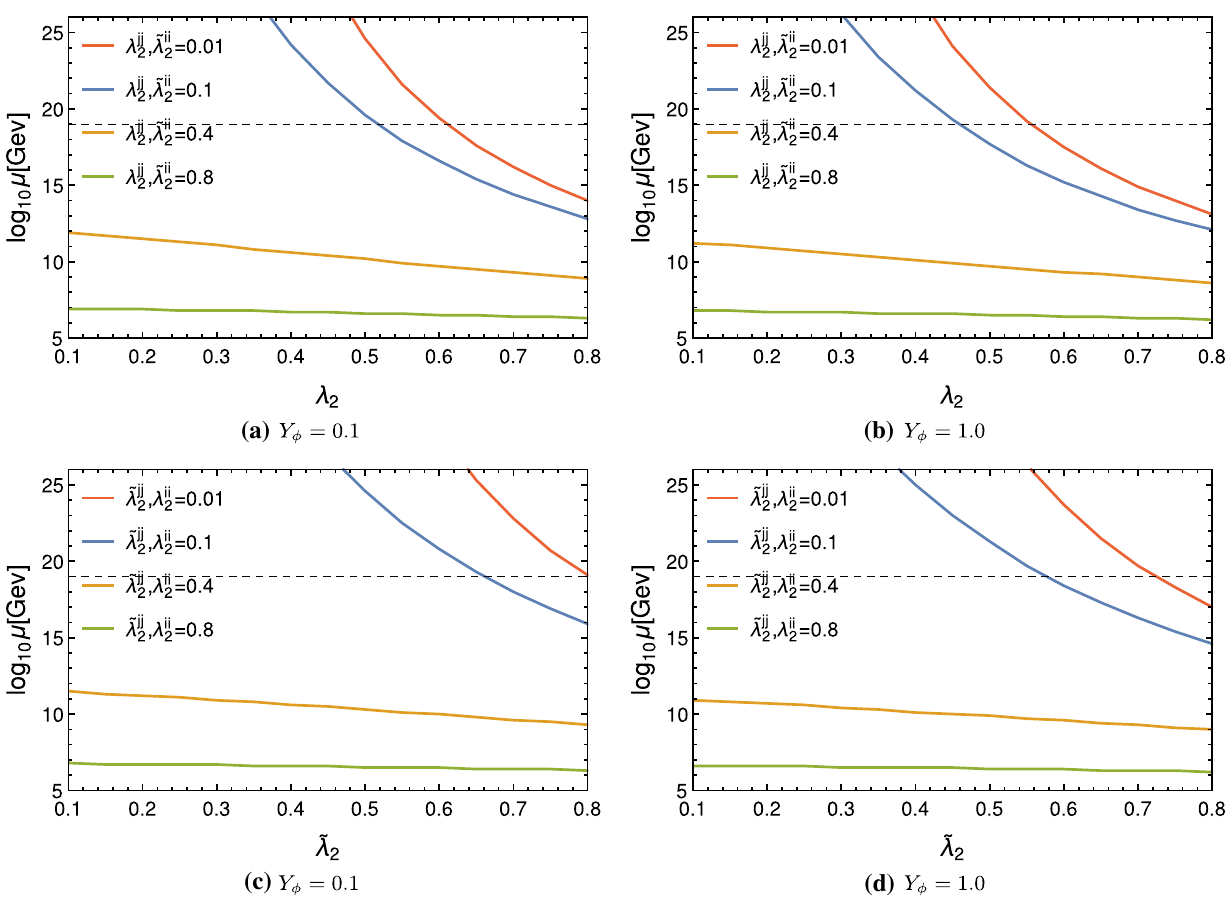
Fig. 4 Variation in leptoquark-Higgs quartic coupling λ 2 and (cid:2) λ 2 with blue, orange and green curves, respectively. Similarly, for the plots in perturbative scale for the doublet leptoquark (cid:2) R 2 with three generations. the second row, (cid:2) λ 2 describes the variation in any particular generation, For plots in the first row, λ 2 variation is considered for any one gener- and the remaining generations are denoted by (cid:2) λ jj . The other quartic coupling terms λ ii are defined for all three generations of leptoquark. . The ation of the leptoquark, and other generations are defined as λ jj 2 2 The variations are considered for lower and higher values of Y φ , i.e. 0.1 for all three generations other quartic couplings are designated by (cid:2) λ jj 2 (left) and 1.0 of leptoquark. The variations are taken for four different EW values of quartic couplings, i.e. 0.01, 0.1, 0.4 and 0.8, which are depicted by red,